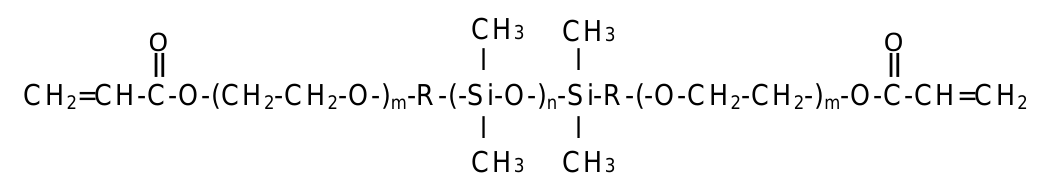
Figure 3. Molecular structure of diacrylated silicone polyether oligomer.